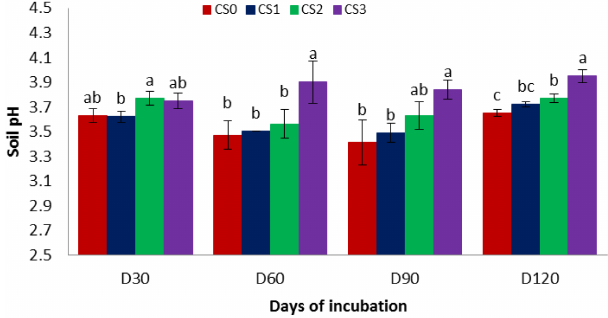
Figure 2. Effects of calcium silicate application on exchangeable aluminum. Means marked with the same letter for each incubation day are not significantly different at p< 0 . 05 (Tukey‘s